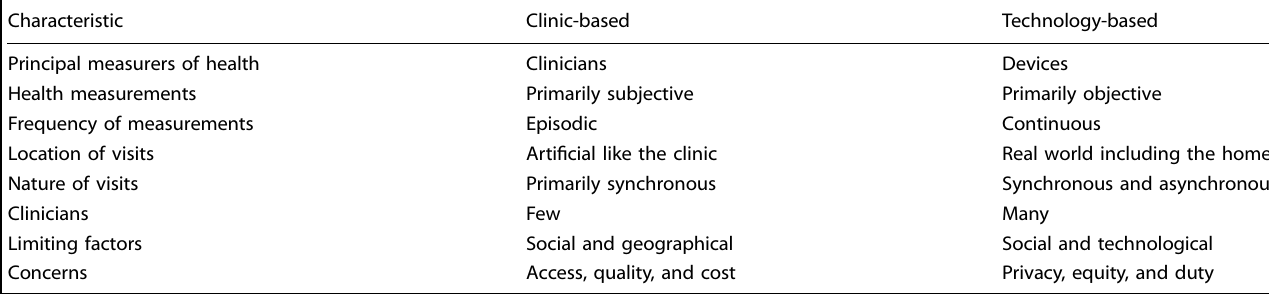
Table 1. Comparison of health care platforms.